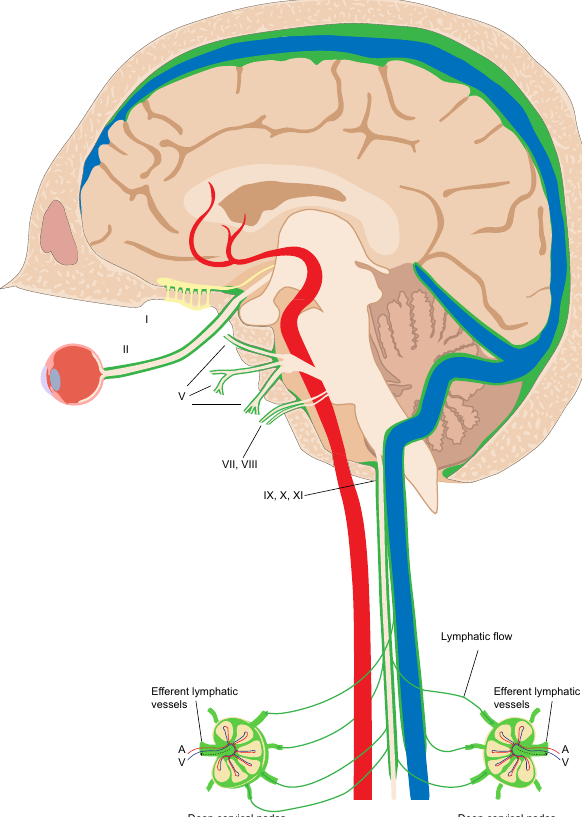
Fig. 9 Schematic model of the brain lymphatic system and its drainage pathways. The overall system is divided into dorsal and ventral systems. The dorsal system includes ISF-lymphatic fl uid present along dural venous sinuses that drains along the jugular veins and foramen magnum. The thickest of these fl uid spaces occurs at the midsagittal level. Decreased caliber of this space present at the level of the posterior sagittal sinus is most likely due to effects of gravity while in the supine position during scanning. The ventral system includes ISF-lymphatic fl uid along the olfactory nerves in the anterior cranial fossa, optic groove, dura at the ori fi ce of the Meckel ’ s caves, dura at the ori fi ce of the internal auditory canals, and dura at the level of the ori fi ces of jugular foramen. The green signal at the ori fi ces of neural foramina represents lymphatic fl uid. These pathways channel ISF-lymphatic fl uid outside of the intracranial along the space epidural surfaces of the cranial nerves. ISF-Lymphatic signals along the cranial nerves, jugular veins and petrous and cervical ICAs in the neck show connections between each other and cervical lymph nodes. The schematic depicts direct connections between meningeal ISF-Lymphatic fl uid to deep neck nodes via multiple neural foramina and along the skull base structures in dorsal mLVs compared with young mice 26 . Our fi ndings of prominent change within the dorsal structures in humans may be related to morphological differences between mouse and human brains such as the more developed telencephalon in humans.